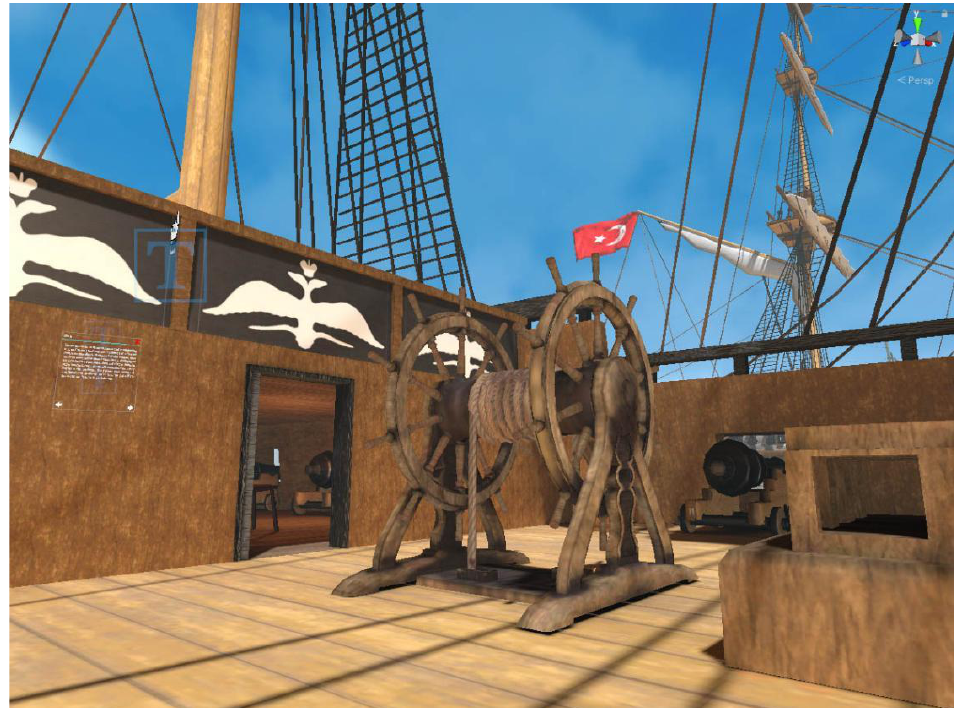
Figure 12 . Azov’s deck. Screenshot from the environment of the Unity3d Game Engine.